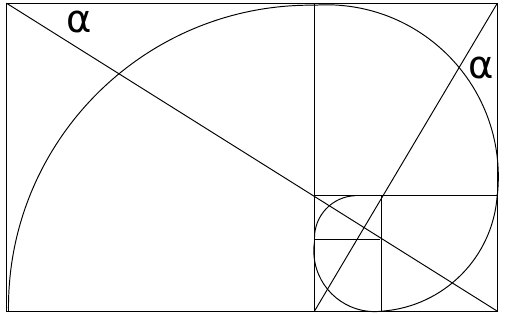
Figure 1. The golden logarithmic spiral. tan α = τ